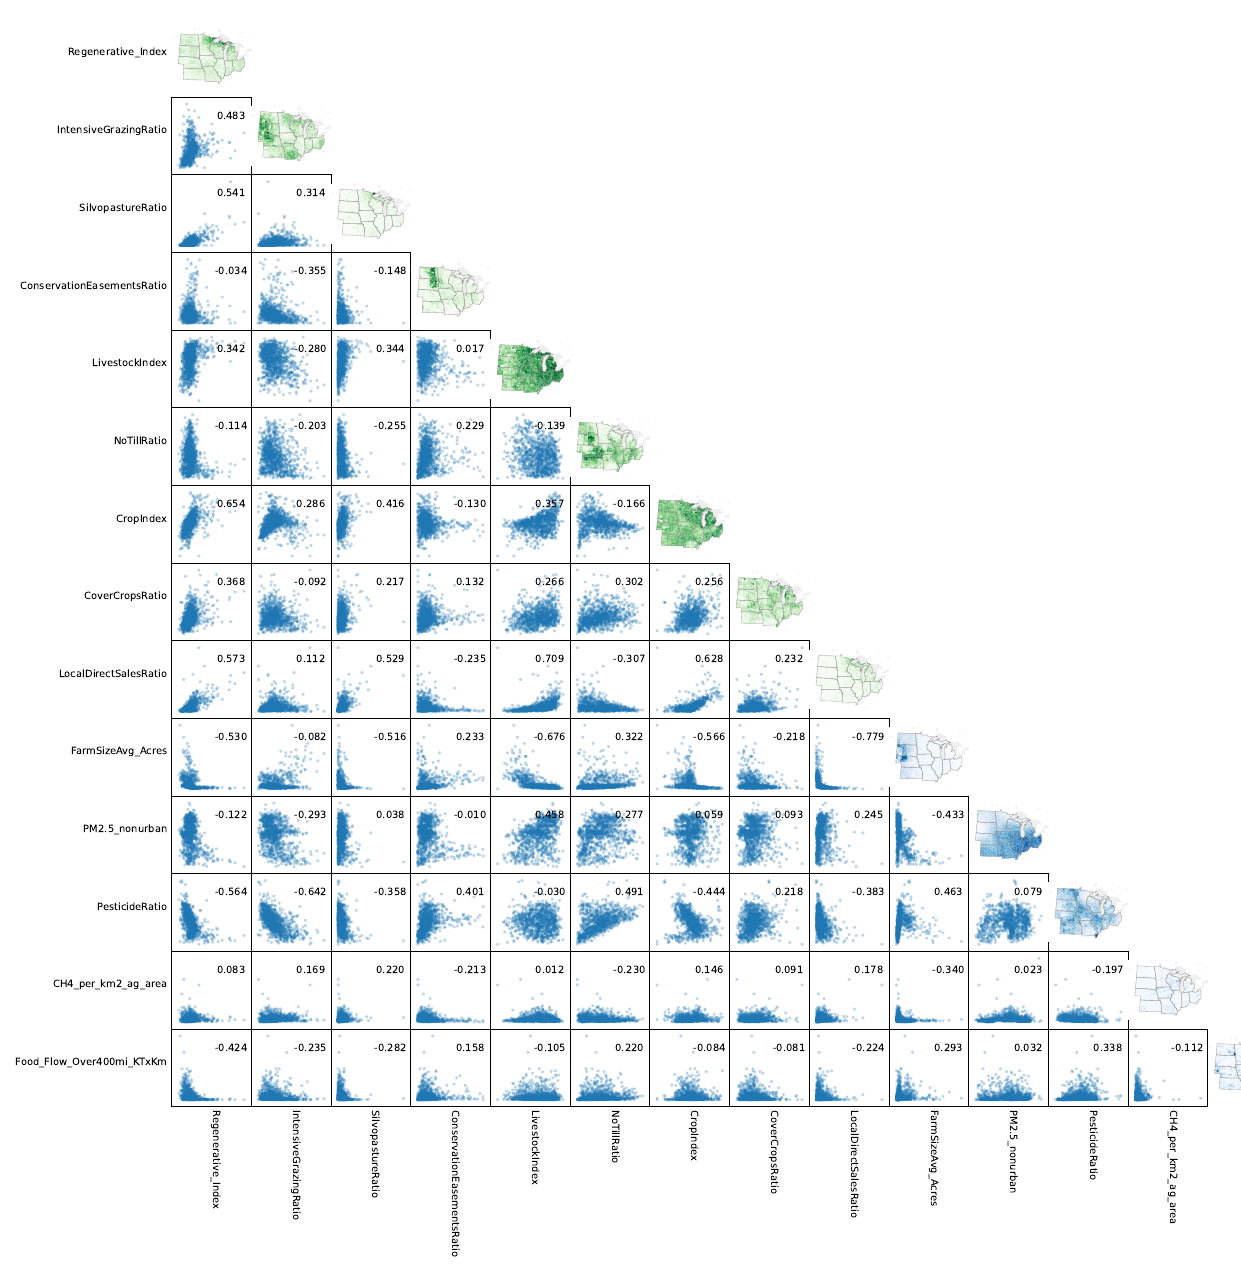
Figure A15. Exploration of relationships among regenerative–conventional agricultural index vari- ables. Scatter plots at the intersection of a given row and column corresponding to particular variables show the relations among those variables. Numbers are Spearman’s rank correlation coefficients. Maps along the diagonal show the spatial distribution of each